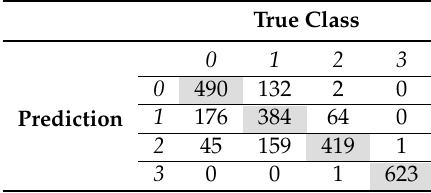
Table 1. Confusion matrix of the CNN for HER2 scoring in IHC tiles.